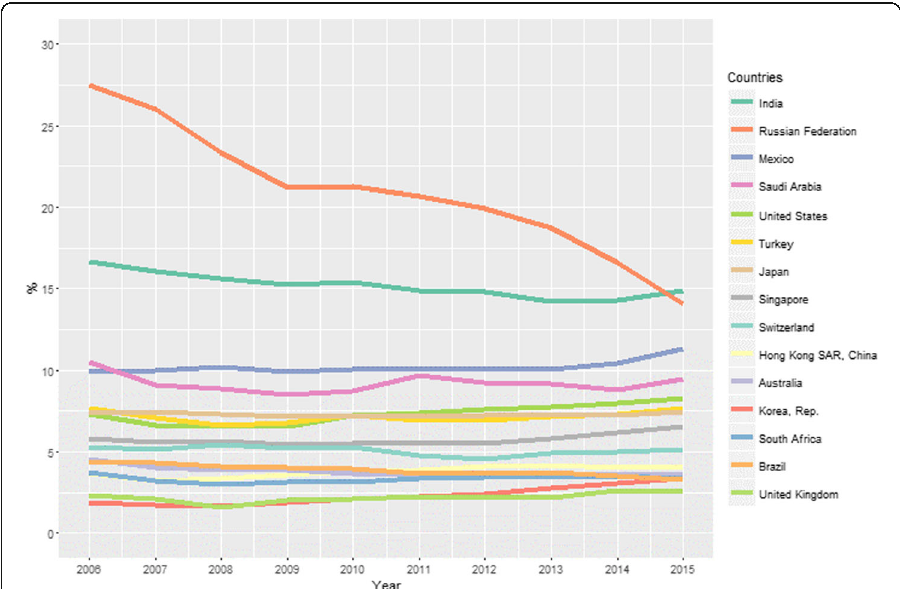
Fig. 2 Ratio of cash in circulation outside banks to broad money (M4), 2006 – 15%, BIS Red Book countries with available data. CPMI (2016), CPSS (2012), IMF (2015). Annual data refers to the position on the year ’